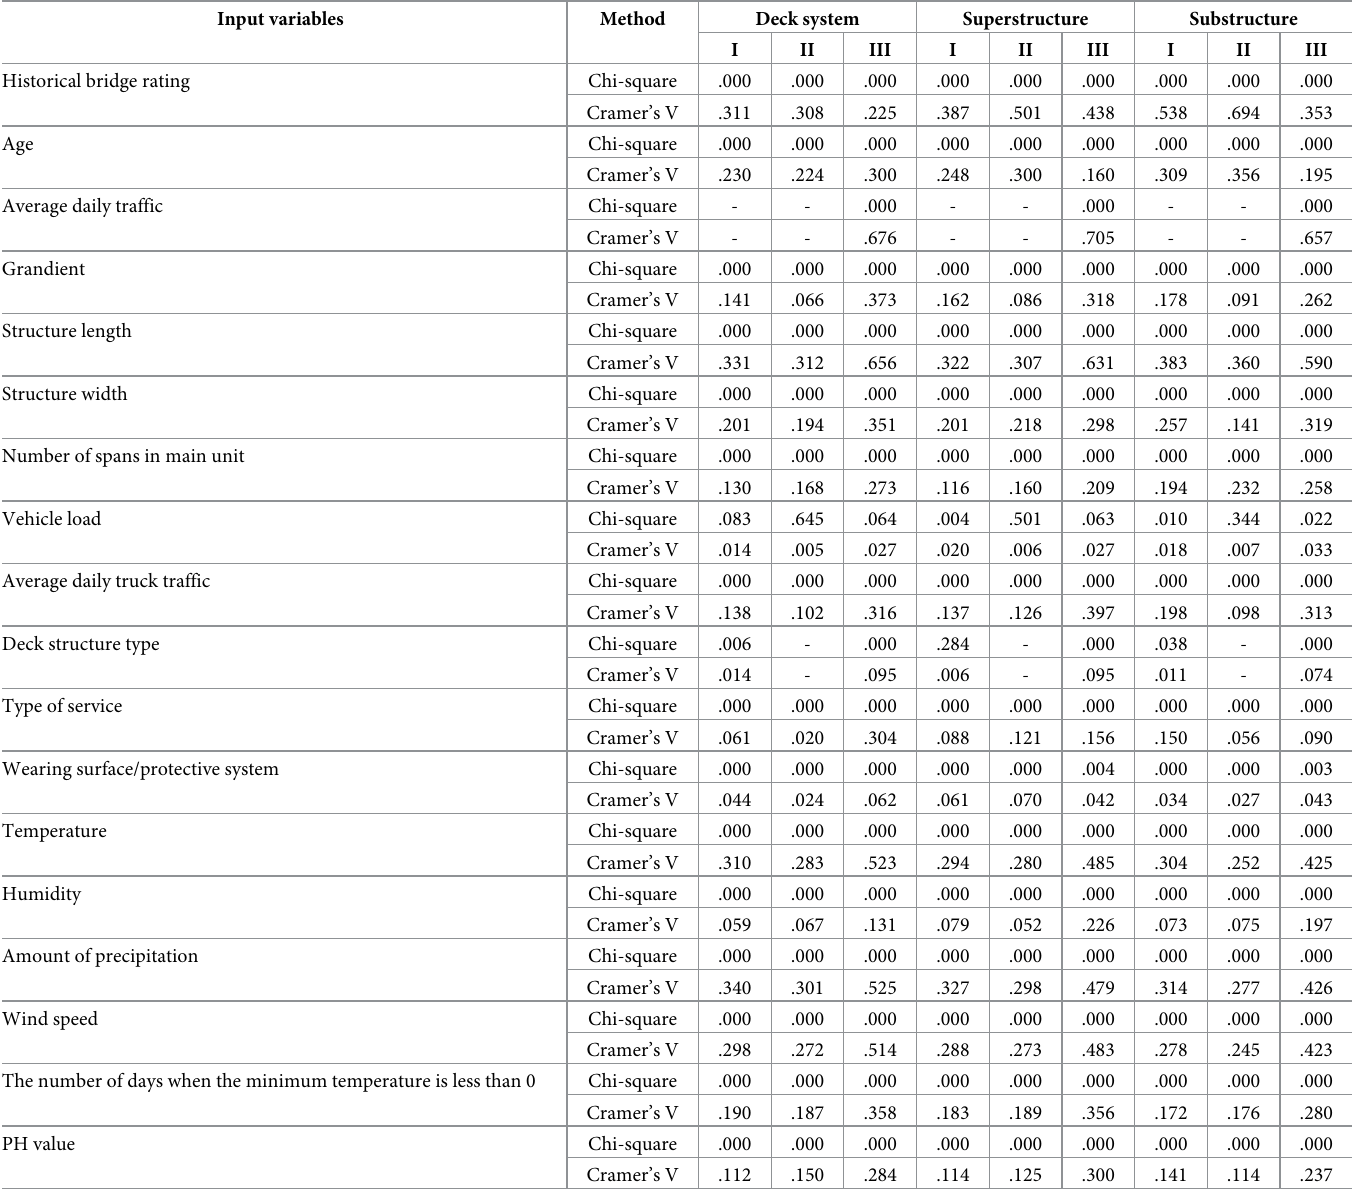
Table 8. Chi-square and Cramer’s V test